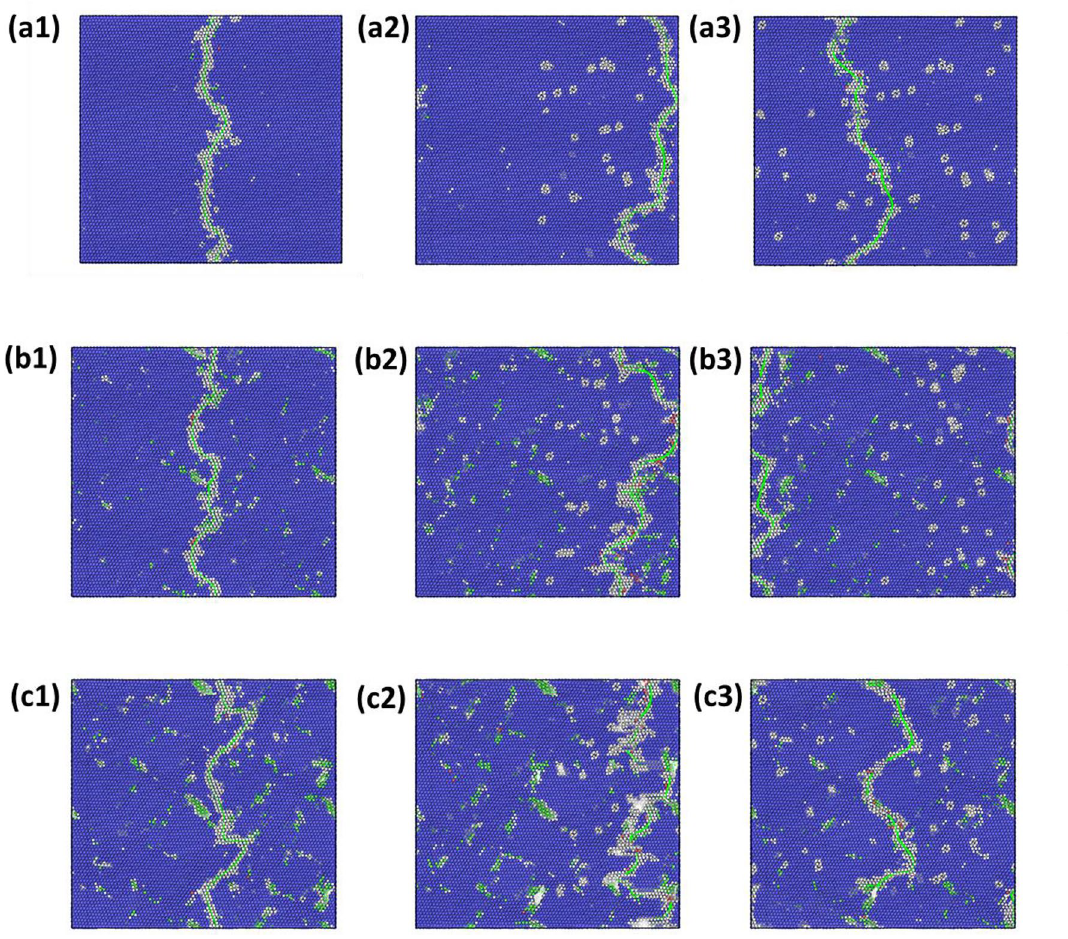
Figure 3. Edge dislocation movement from left to right under applied shear stress: ( a1 – a3 ) are stages for 0 swap, ( b1 – b3 ) for 5 swaps and ( c1 – c3 ) for 10 MC swaps. The atomistic structures as shown in this figure are made by OVITO 2.9.0. URL: https ://www.ovito